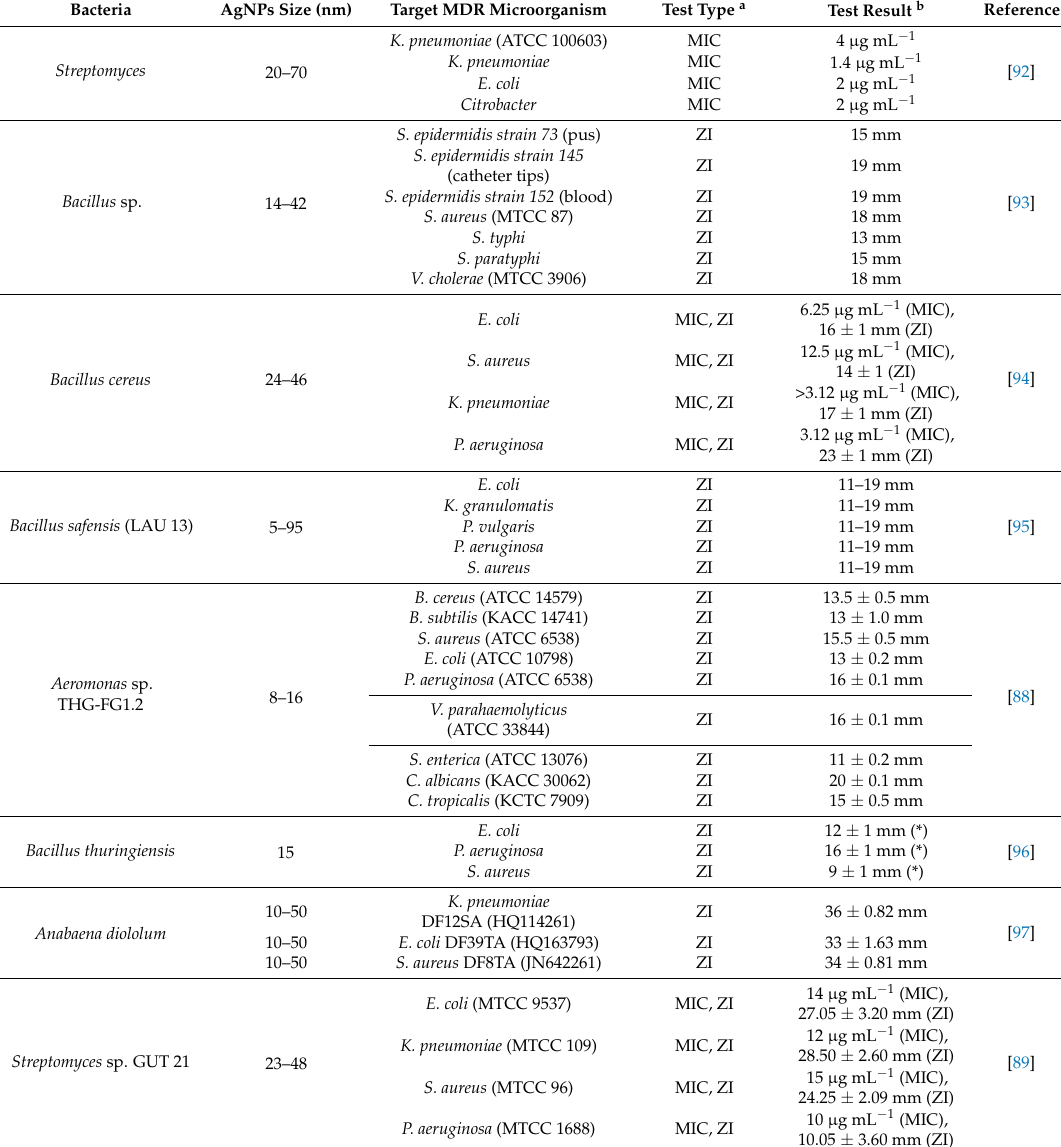
Table 2. Bacteria-mediated AgNPs biosynthesis and their activity against MDRB.